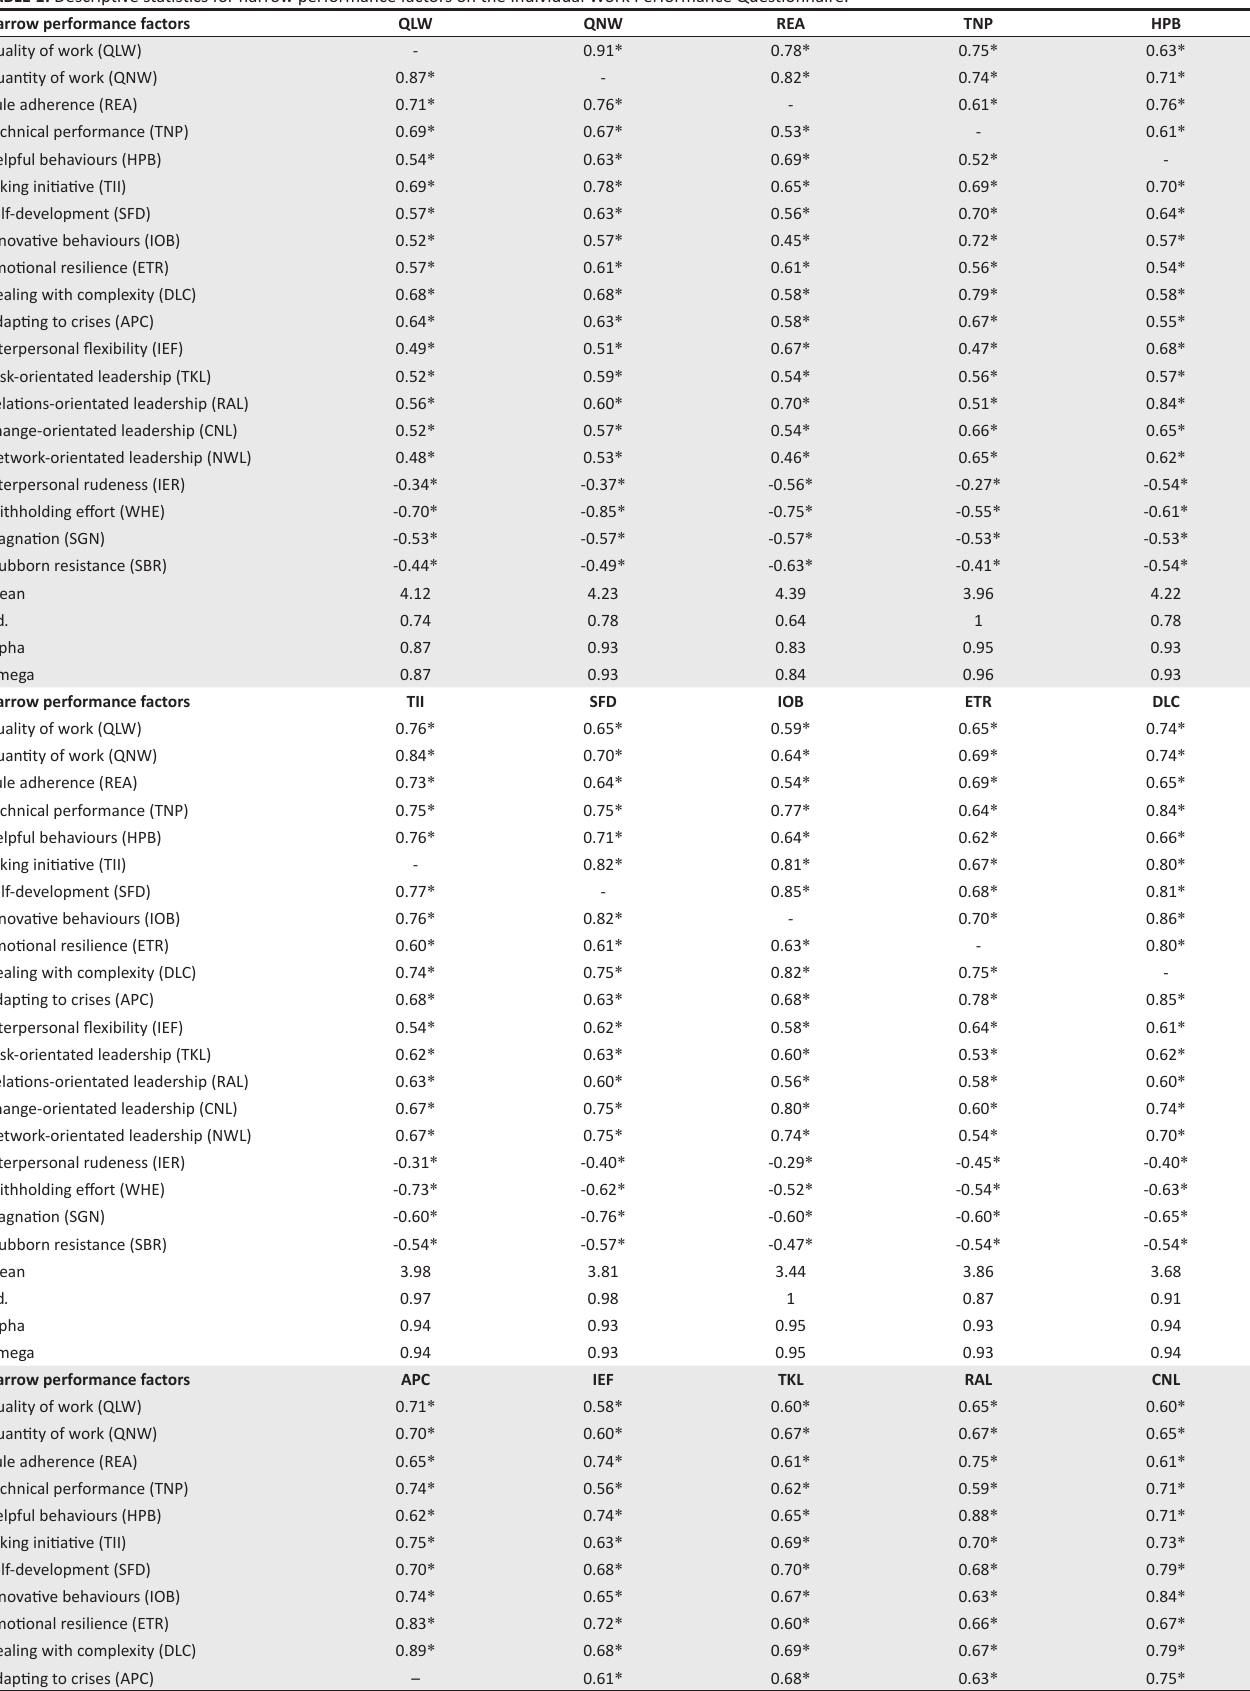
TABLE 1: Descriptive statistics for narrow performance factors on the Individual Work Performance